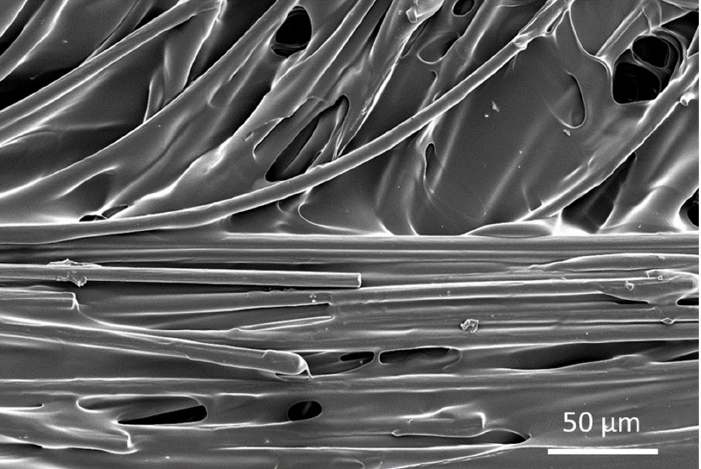
Figure 10. SEM analysis showing fibre distribution with resin, along with voids between deposited filaments.